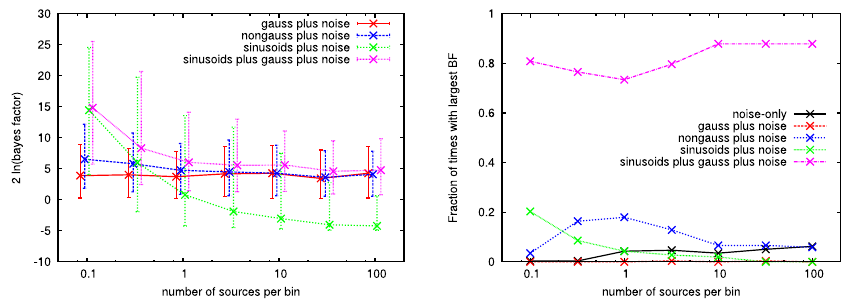
Fig. 60 Left panel Bayes factor 80% quantile intervals for the four different signal-plus-noise models relative to the noise-only model as a function of the number of sources per bin. Right panel Fraction of time that the different models had the largest Bayes factor for the different simulations. Image reproduced with permission from Cornish and Romano (2015), copyright by